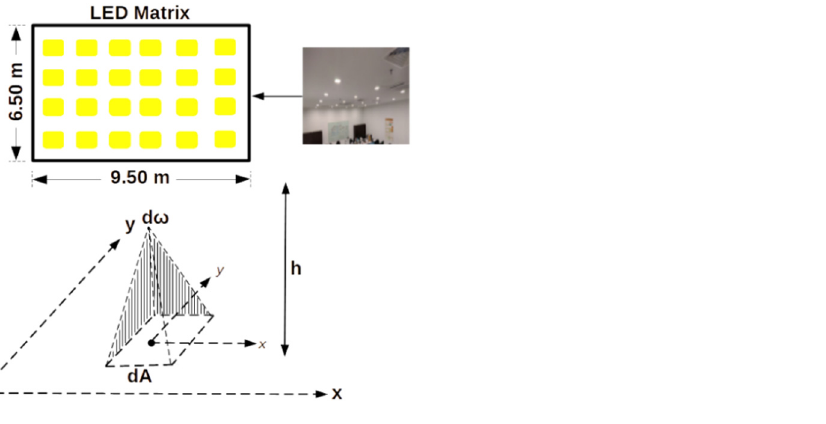
Figure 5. Illustration of the study area, where there are 24 LED ceiling lamps; each LED has a maximum luminance of 6600 lux.